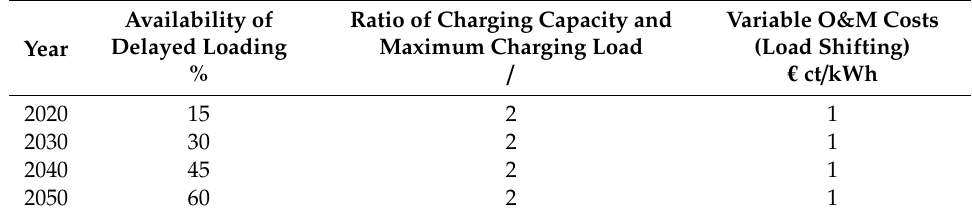
Table 3. Assumed economic and technological parameters for electric cars [35].